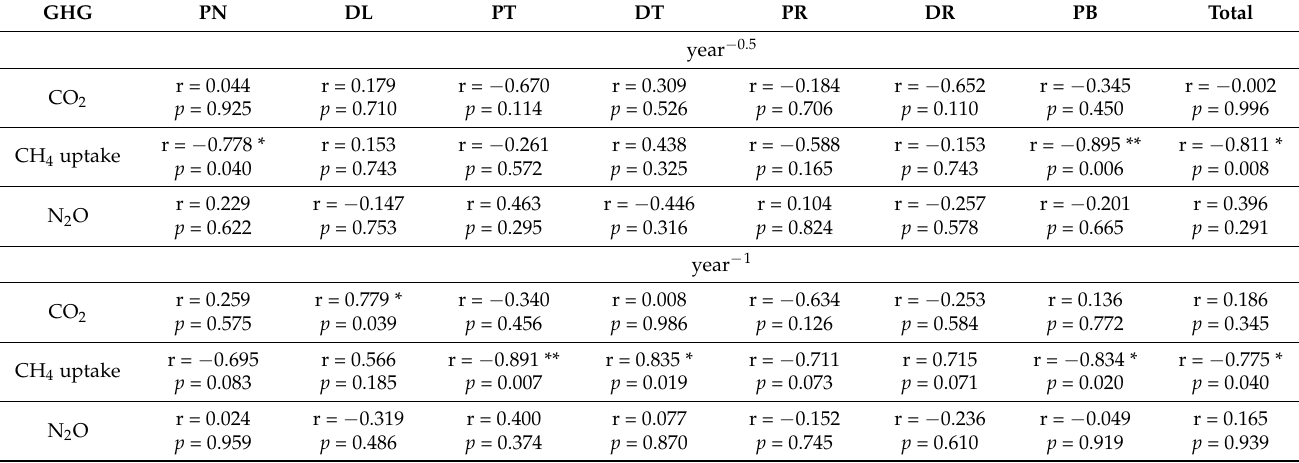
Table 5. Pearson correlation analysis among GHG fluxes and litterfall fractions in two